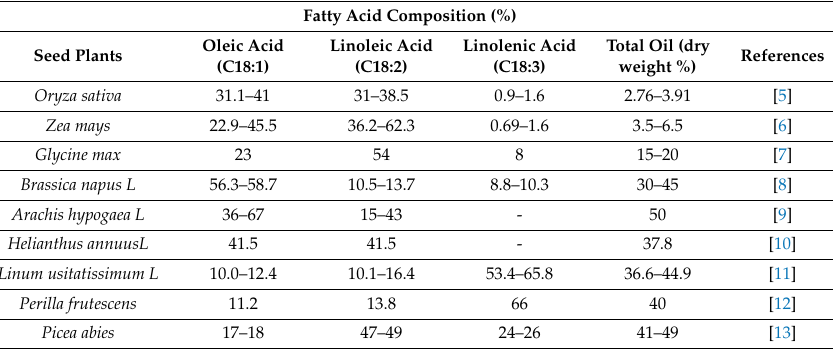
Table 1. The composition of fatty acids in the seed